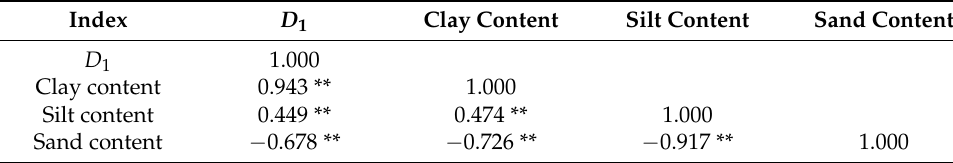
Table 3. Correlation between fractal dimension of soils and soil mechanical composition. Index D 1 Clay Content Silt Content Sand Content D 1 1.000 Clay content 0.943 ** 1.000 Silt content 0.449 ** 0.474 ** 1.000 Sand content − 0.678 ** − 0.726 ** − 0.917 **